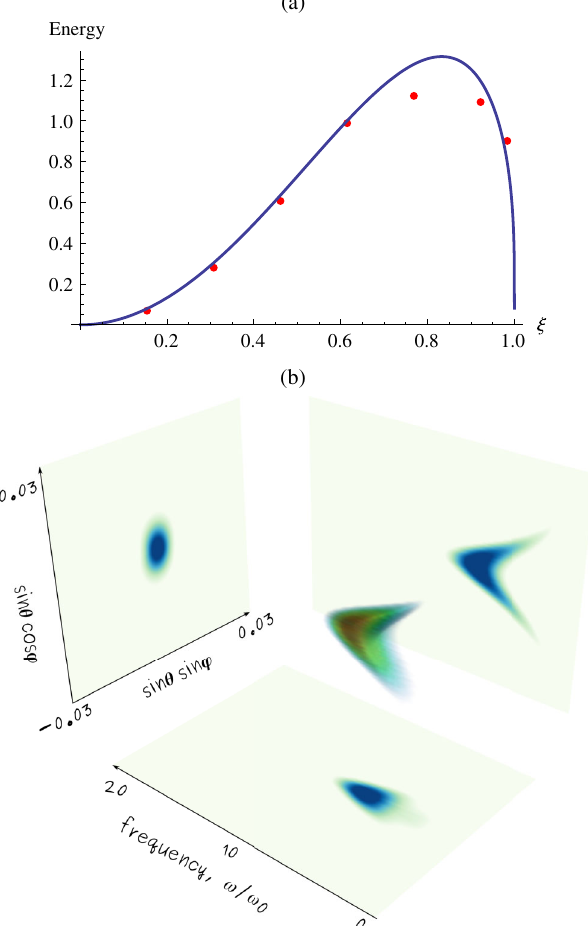
=c ffiffiffi p 0 a 2 (a), calcu- 0